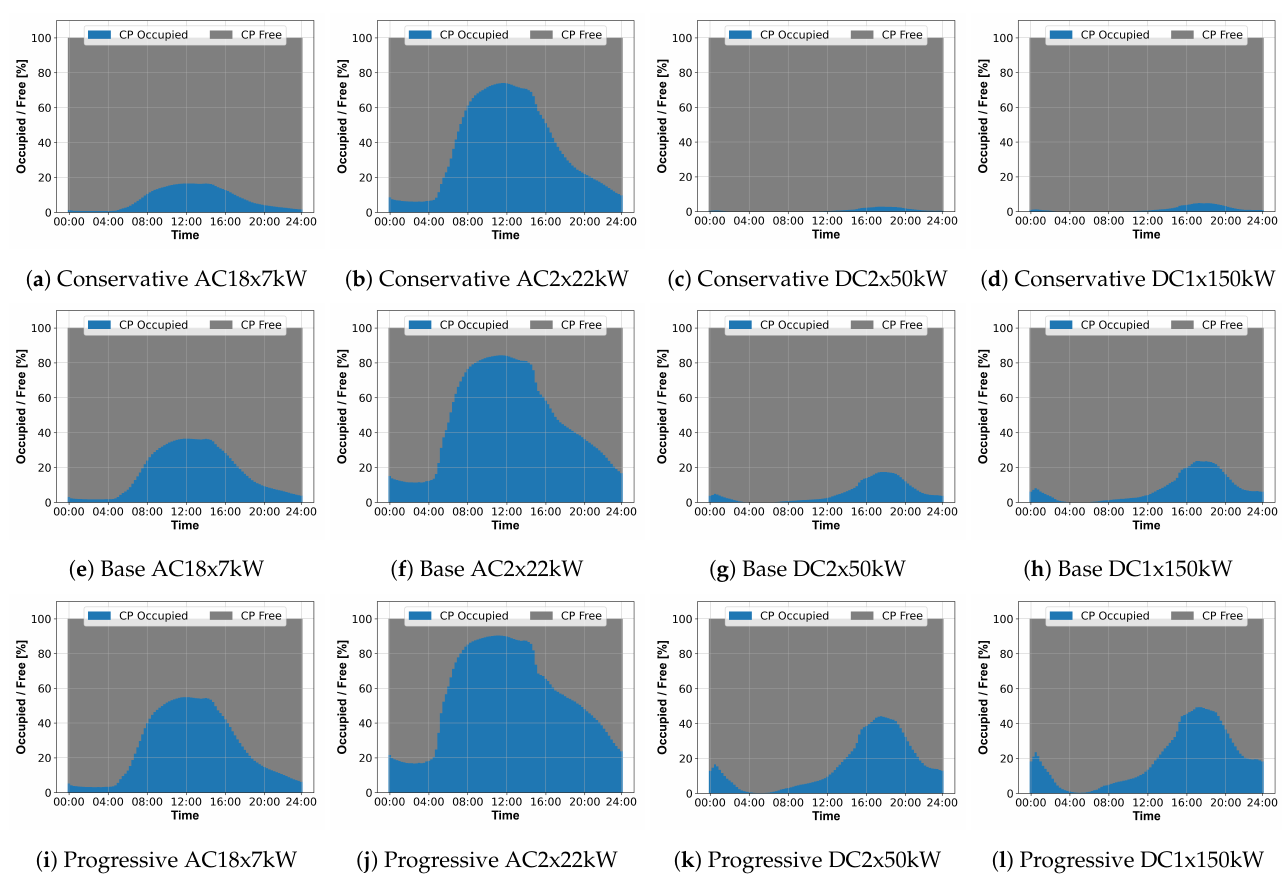
Figure 10. Occupation of the charging points of different charging concepts for the defined